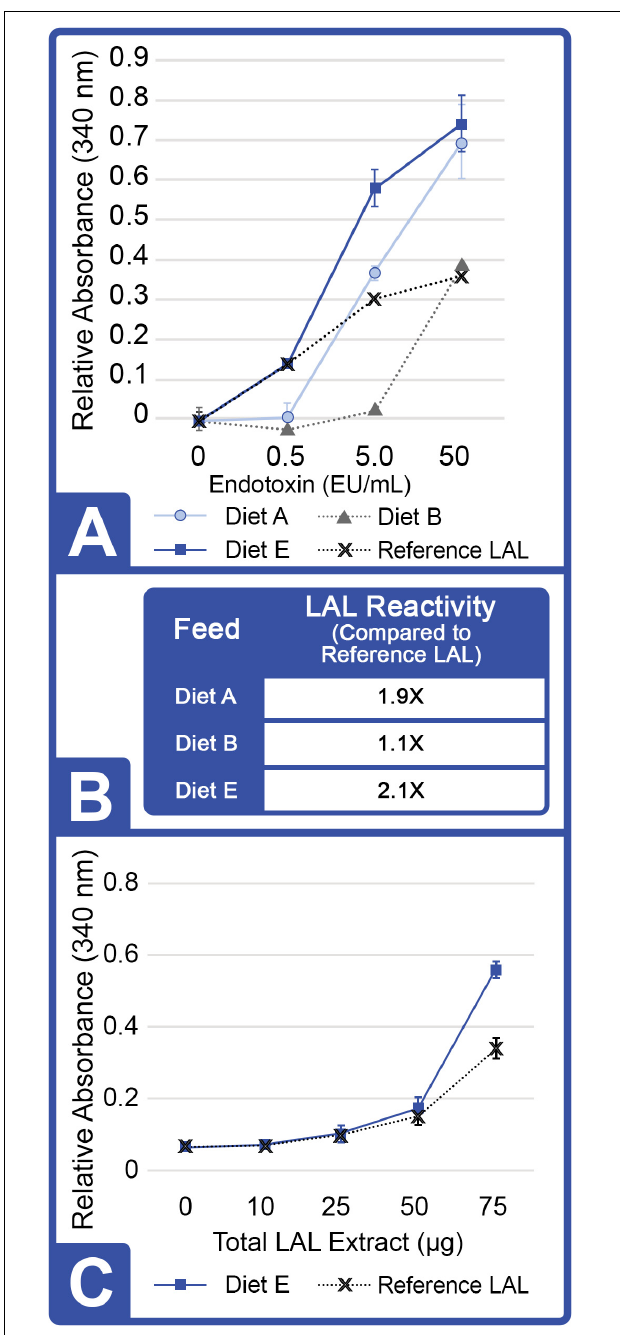
FIGURE 2 | Effect of diet on LAL reactivity to endotoxins (Feed Study 1). (A) Gel formation measured by absorbance at 340 nm. Hundred and fifty µ g of aquaculture LAL was evaluated at a range of endotoxin concentrations: 0, 0.5, 5.0, and 50.0 EU/mL with a reference LAL. Results are represented as mean ± SD between individual LAL assays performed in triplicate. (B) LAL reactivity to endotoxin from each diet cohort was normalized to reference LAL reactivity at 50 EU/mL of LPS. (C) Reactivity (gelation) of increasing concentrations of LAL (0, 10 25, 50, and 75 µ g total protein) from HSCs fed Diet E vs. reference LAL at 50 EU/mL of LPS measured by absorbance at 340 nm. Results are represented as mean ± SD between individual LAL assays performed in